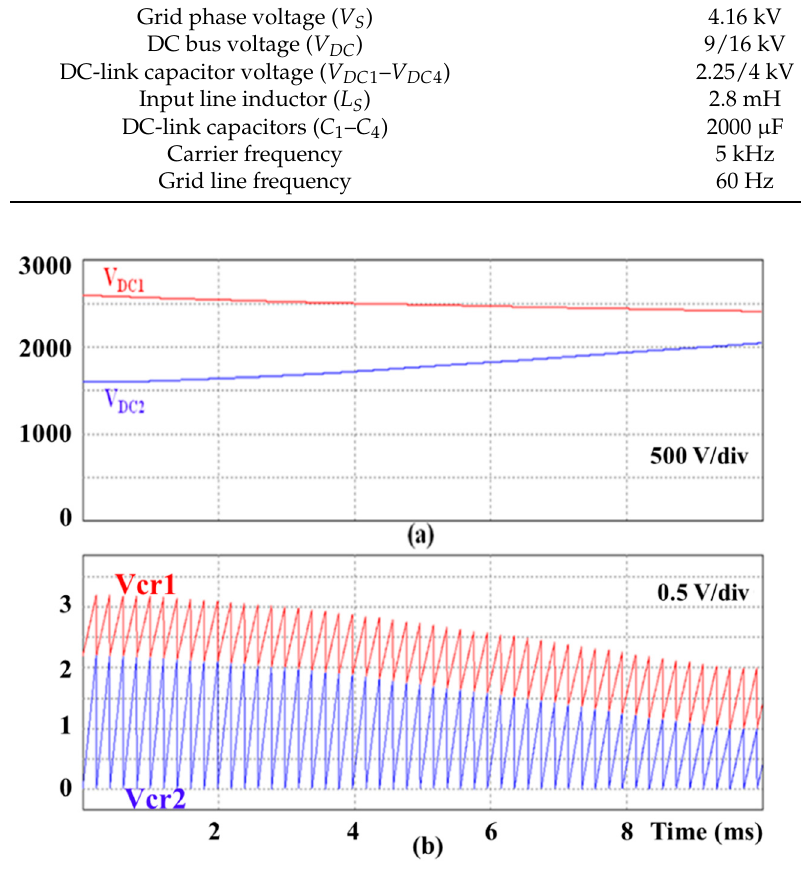
Figure 9. Simulation waveforms of the proposed four-carrier level-shifted OCC PWM control of the five-level OCC MV Regen-Load in region I and II. ( a ) V DC 1 and V DC 2 dc-link capacitor voltages when V DC 1 > V *DC > V DC 2 ; ( b ) Vcr 1 and Vcr 2 carrier signals.